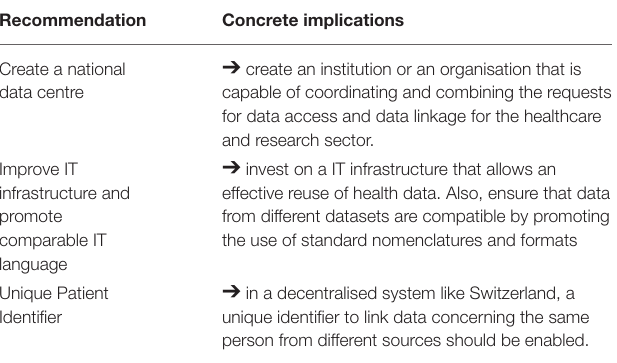
TABLE 2 | Recommendations concerning infrastructure. Recommendation Concrete implications